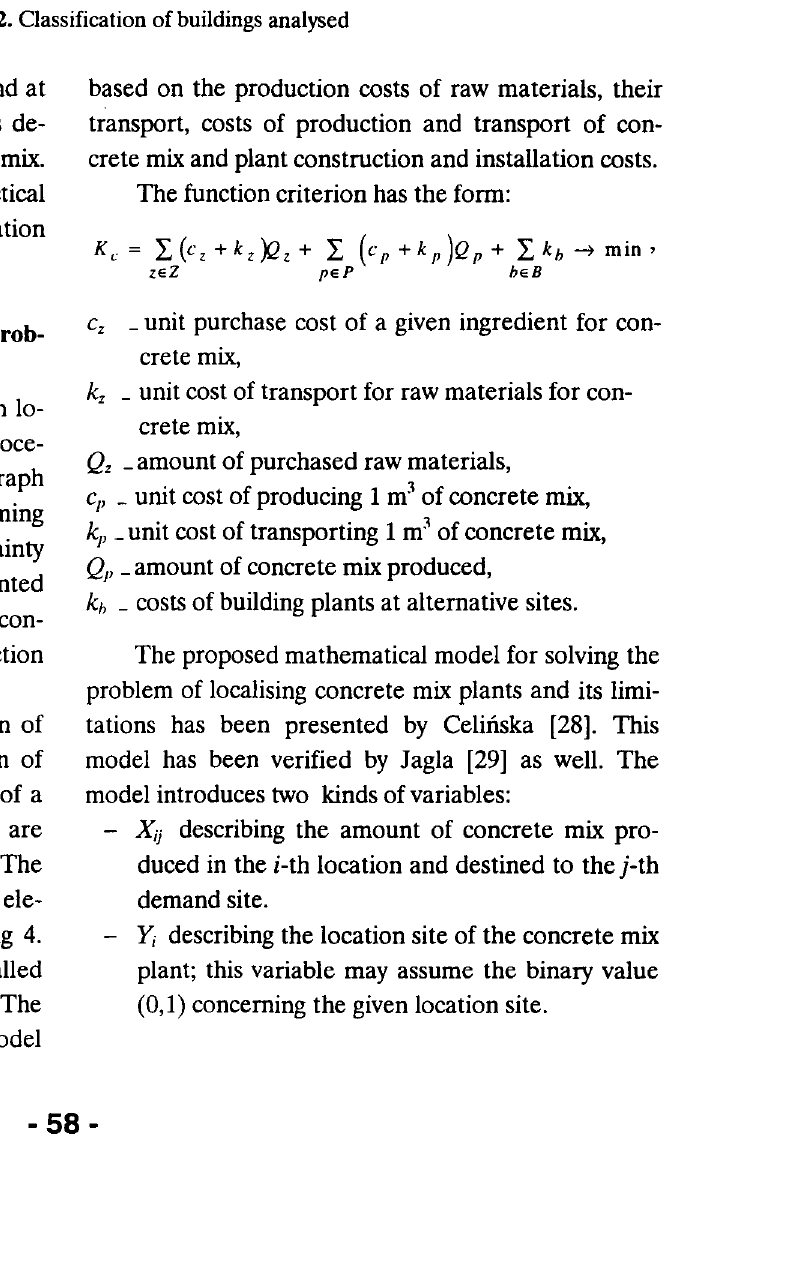
Fig 2. Classification of buildings